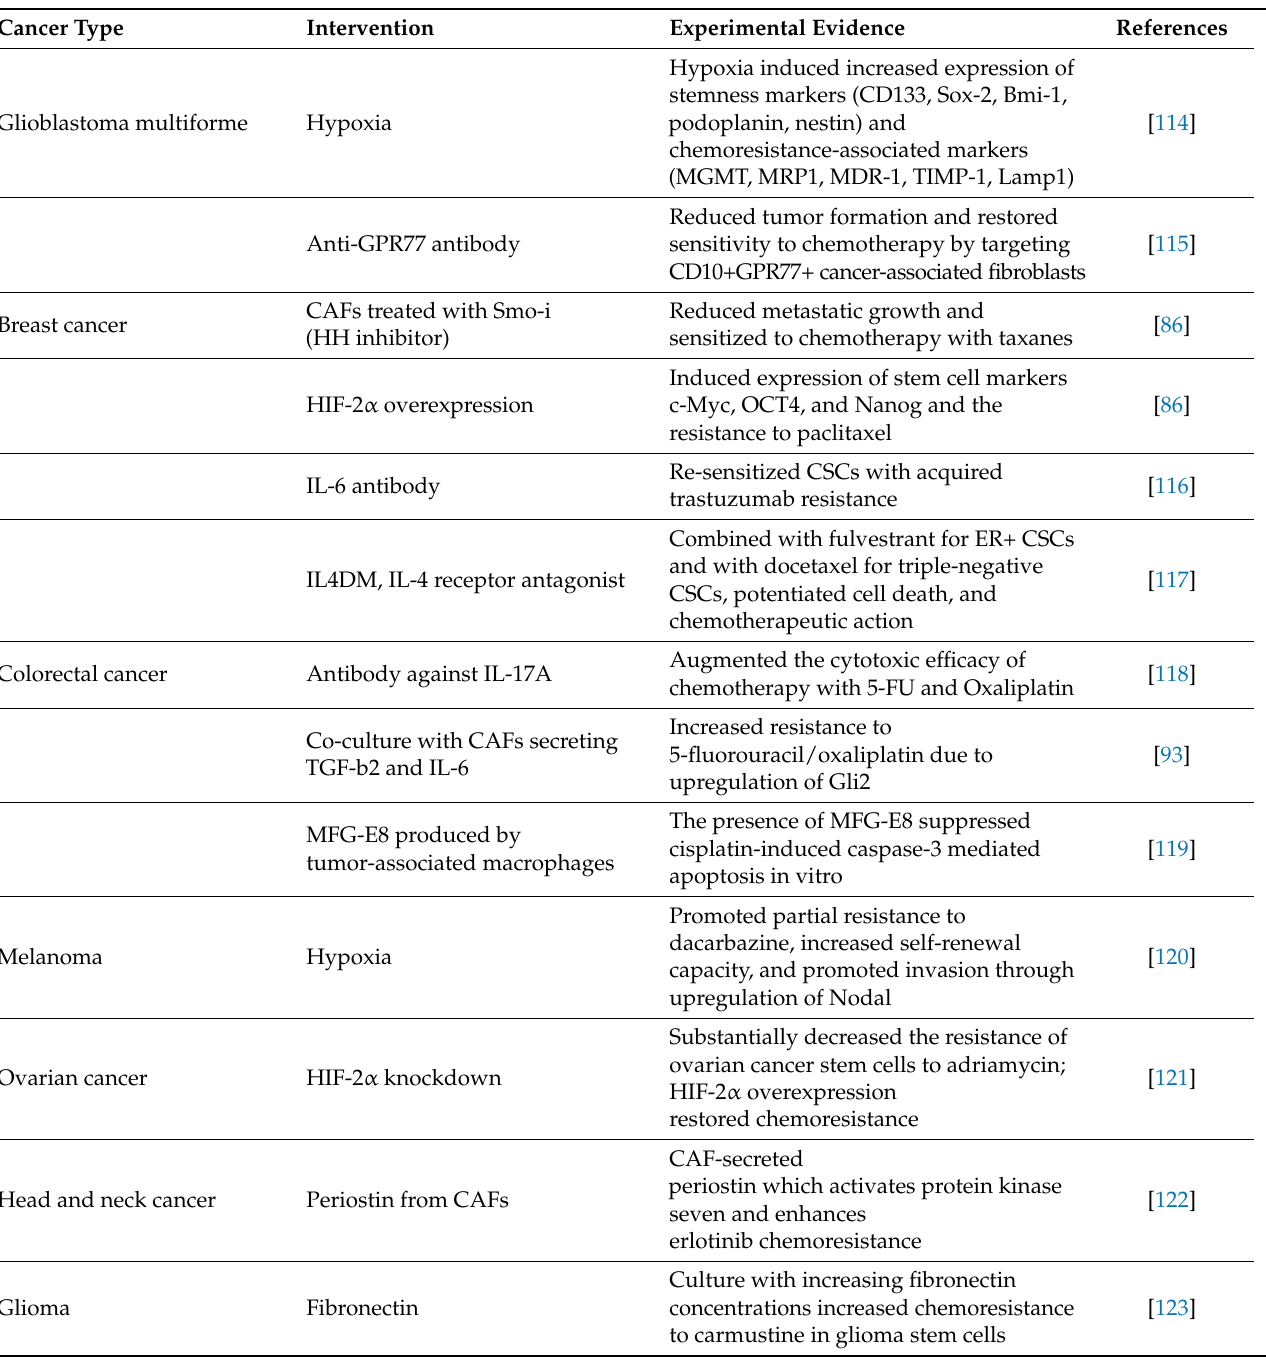
Table 4. Summary of evidence for the role of tumor microenvironment in chemoresistance of cancer stem